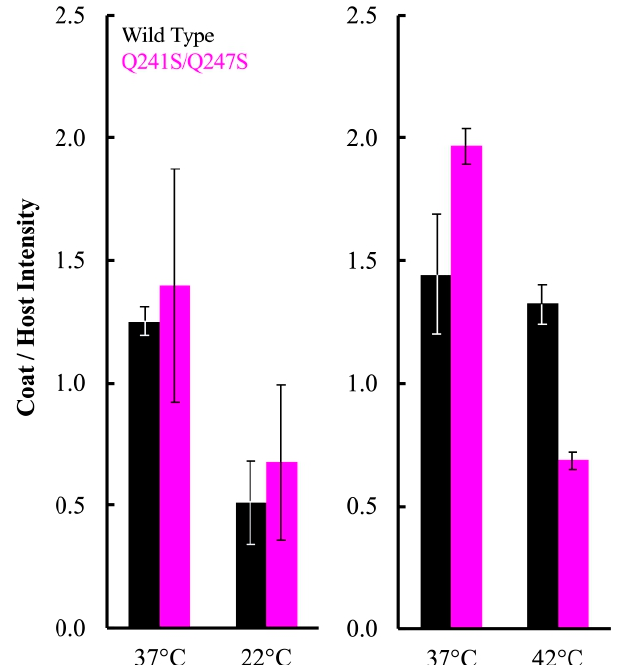
Figure 4. Coat to host protein ratios of cells as a function of the H protein within the infecting particle. The infecting virions were generated in am(H)M251 infected cells, expressing different H gene clones. These particles were then used to infect lysis resistant cells, expressing a clone of the wild-type H gene. A color legend indicates the H protein found in the infecting particles. The infection temperatures are on the X-axes. Panel figures depict the results of two experiments conducted at one of the restrictive temperatures, 22 ◦ C and 42 ◦ C, each with a separate 37 ◦ C control. Error bars represent the standard error of the mean calculated from three ( left ) or two ( right ) biological replicates.